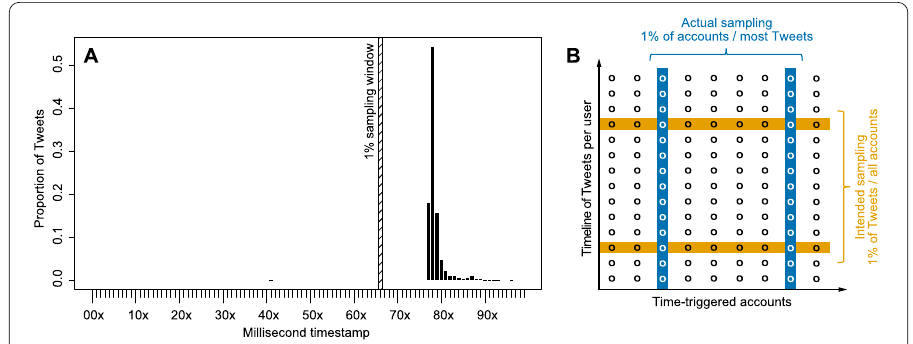
Figure 6 Twitter’s tampered samples. ( A ) Sampling artifact created by a time-triggered frequency bot. For several hours, we sent a Tweet exactly every 42 seconds. The bar-graph shows the distribution of milliseconds of the Tweets’s ID. Most Tweets are in a very narrow range, none is in the 1% Sample API time window. ( B ) Schematic representation of Tweet selection process for time-triggered accounts (x-axis). Accounts send Tweets (circles) over time (y-axis). Statistically sound sampling would give every Tweet from every account the same chance of being in the sample. Instead, Twitter’s sampling mechanism selects a large amount of